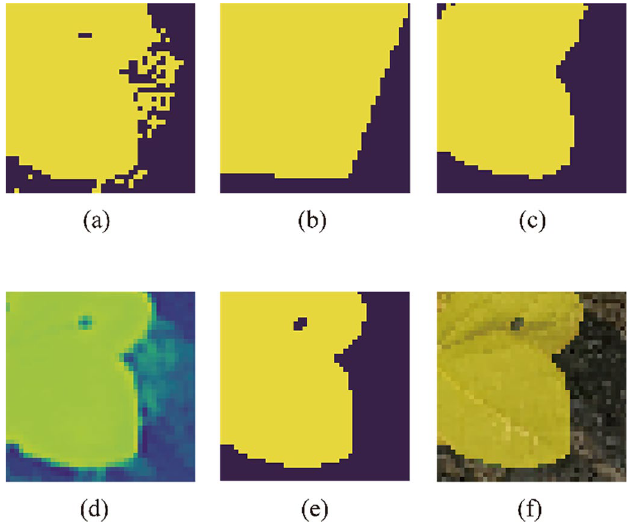
Figure 12. Local output results for the Bean-Field dataset. ( a ) threshold label, ( b ) manual label, ( c ) fine label, ( d ) output of the model, ( e ) output on which a threshold is applied, ( f ) overlay on the input image. In the output image of the trained model, the noise seen in the threshold label is well removed and the holes on the leaf are accurately indicated.